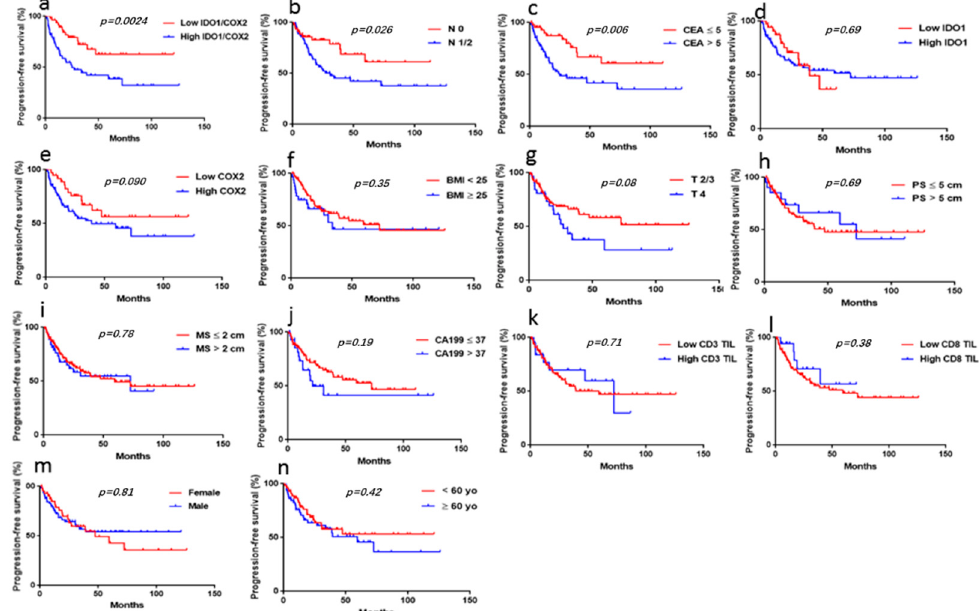
Figure 3. Correlation of the clinicopathological parameters with PFS in CRC patients with liver oligometastases. Survival curves were generated using the Kaplan–Meier method, and differences between survival curves were estimated using the log-rank test. ( a ) We divided all patients into four groups based on IDO1 and COX2 expression levels. Group I: IDO1LowCOXLow; Group II: IDO1HighCOXLow; Group III: IDO1LowCOXHigh; Group IV: IDO1HighCOXHigh. The association of the four groups (IV vs. I/II/III) with PFS was significant ( p = 0.0024); ( b , c ) correlation between CEA and N stage and PFS in patients; c: N stage ( p = 0.026); b: CEA ( p = 0.006). ( d – n ): Correlation between other clinicopathological parameters and PFS in patients. ( p > 0.05).